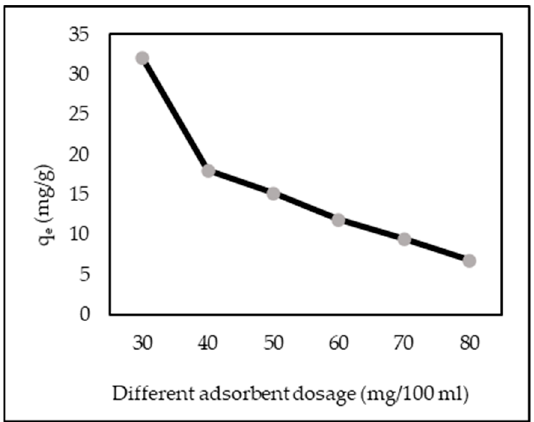
Figure 4. Effect of different adsorbent dosages (ZL–CH hydrogel) (pH 2.0, 100 mL of 10 mg/L AR88, contact time 15 min).